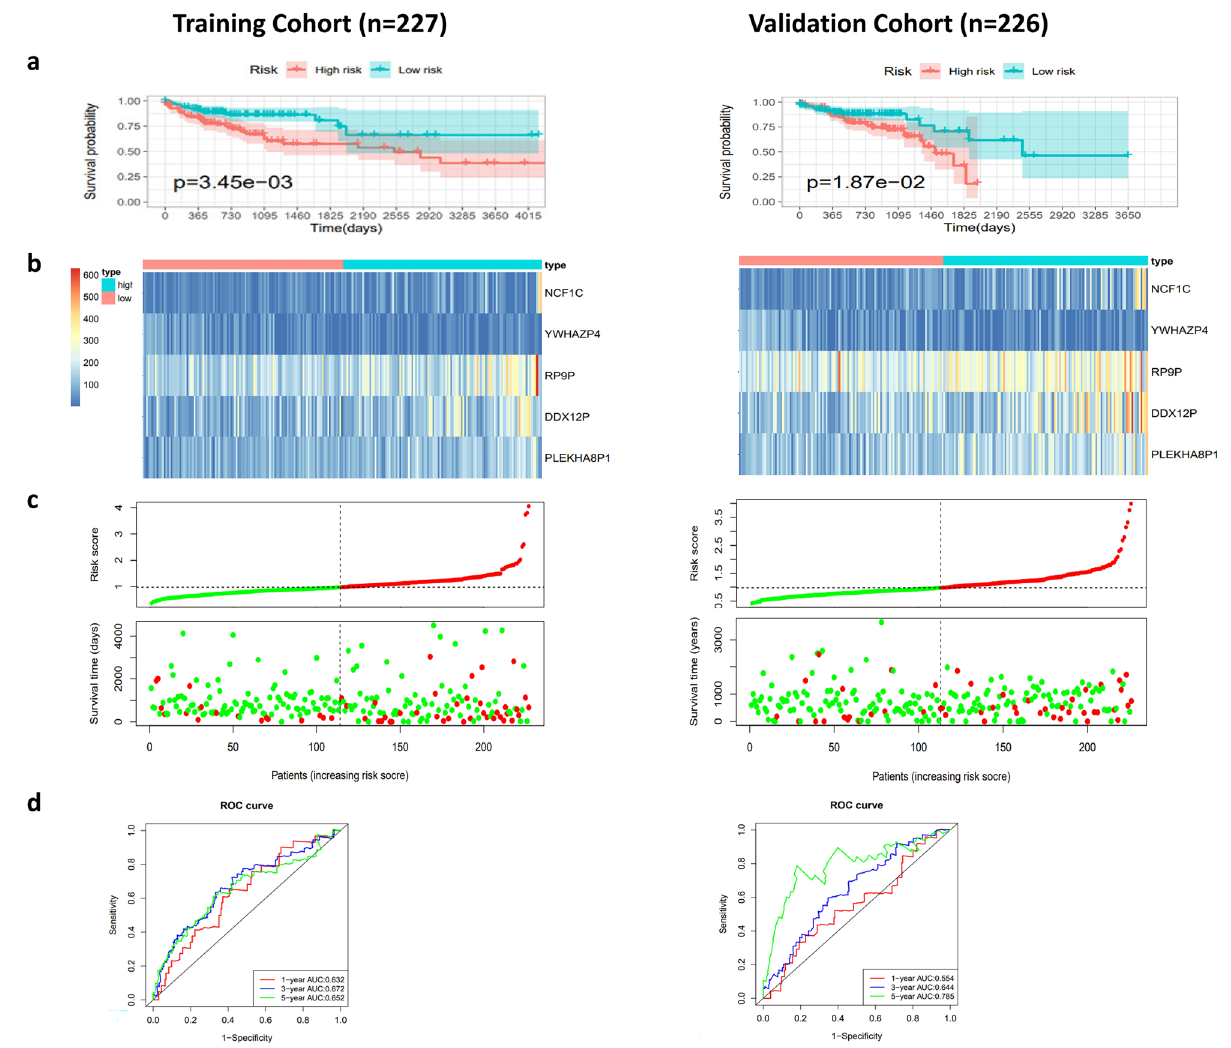
Figure 5. Characterization of the five-pseudogene risk signature in the ceRNA network in the training and validation cohorts. ( a ) Kaplan–Meier curves for high-risk and low-risk groups classified by the risk scores of this signature. ( b ) The expression profiles of the 5 pseudogenes of each sample. The value of risk increased gradually from left to right. ( c ) The risk score distributions and the survival status of CRC patients. The patients were ranked by risk score. ( d ) ROC curves for predicting the 1-, 3-, and 5-year survival of CRC patients according to risk